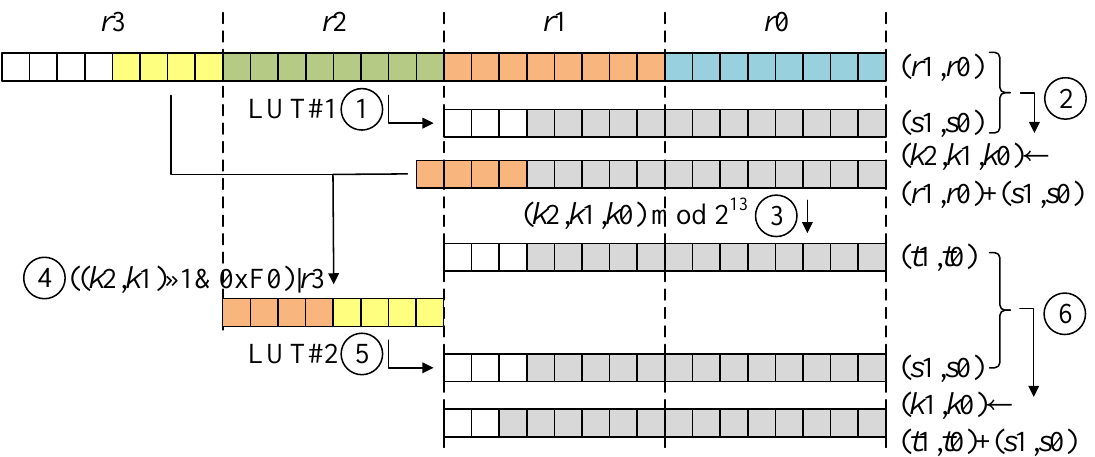
Figure 1. Look-Up Table (LUT)-based Fast Reduction for q = 7681, 1 (cid:13) : LUT access; 2 (cid:13) : addition; 3 (cid:13) : modulo; 4 (cid:13) : concatenation; 5 (cid:13) : LUT access; 6 (cid:13) :